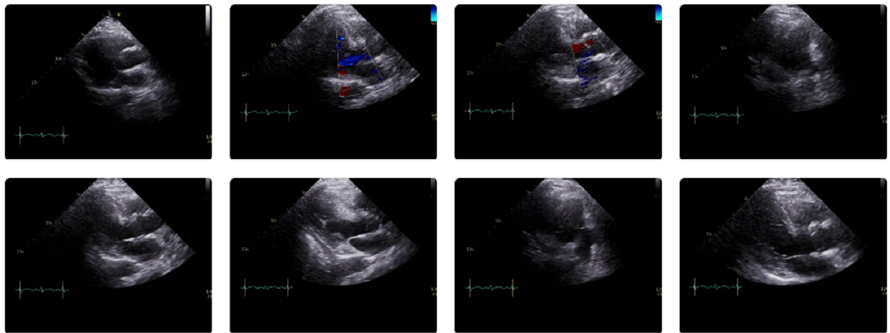
Figure 1. Echocardiogram from 26 October 2022, which showed an ejection fraction of 31% with wall motion abnormalities.